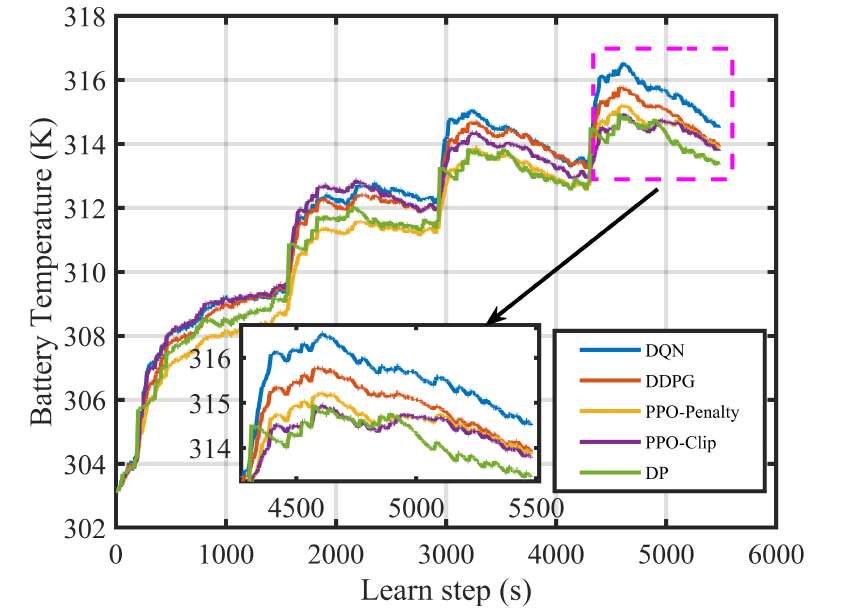
Figure 12. Battery temperature rise curves of different approaches in 4 ×